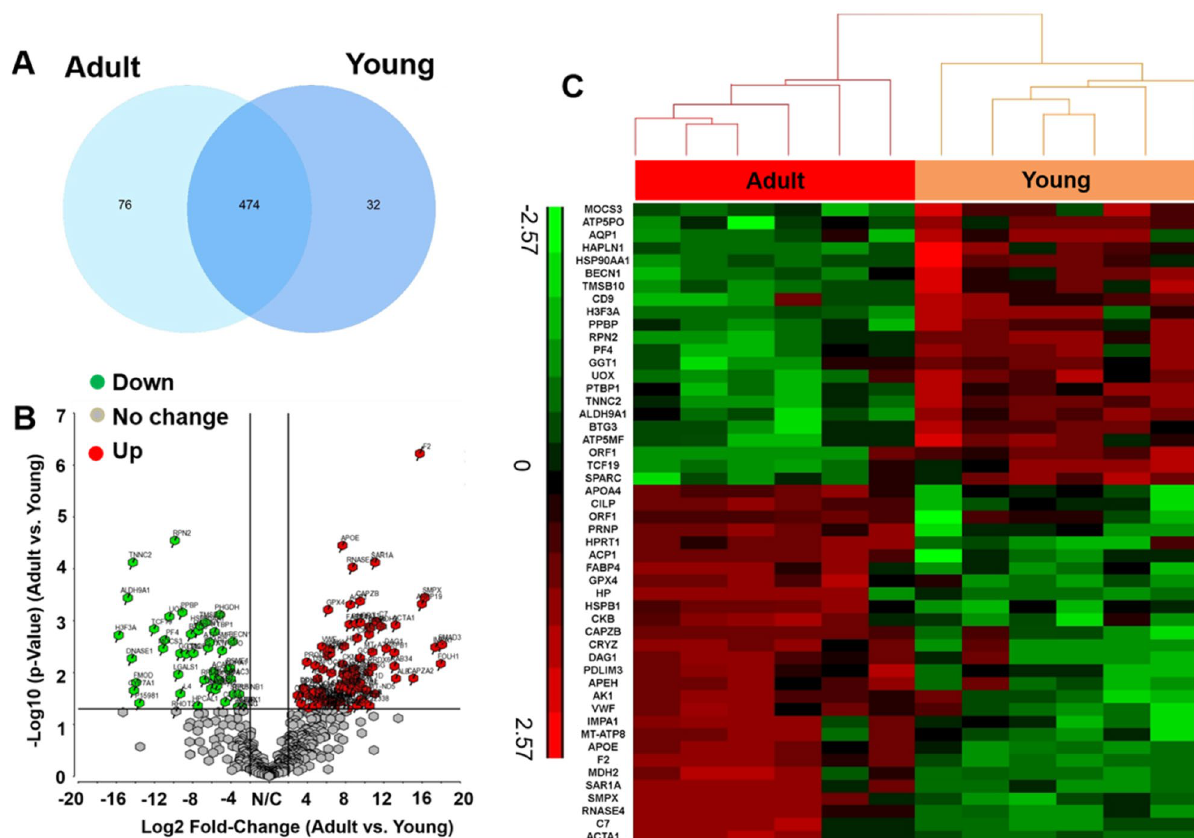
Figure 4. Proteomic profiles of PV leaflets from young and adult pigs. ( A ) The Venn diagram illustrates the overlap and unique proteins identified in young and adult groups; ( B ) volcano plot showing –log (p-value) versus protein fold change (Log2) of all identified proteins. (Red, 60 up-regulated proteins; green, 27 down- regulated proteins; grey, not significantly changed for Adult vs. Young). The solid lines represent a twofold difference in abundance and a p-value < 0.05. ( C ) Heatmap of the 50 most upregulated and downregulated